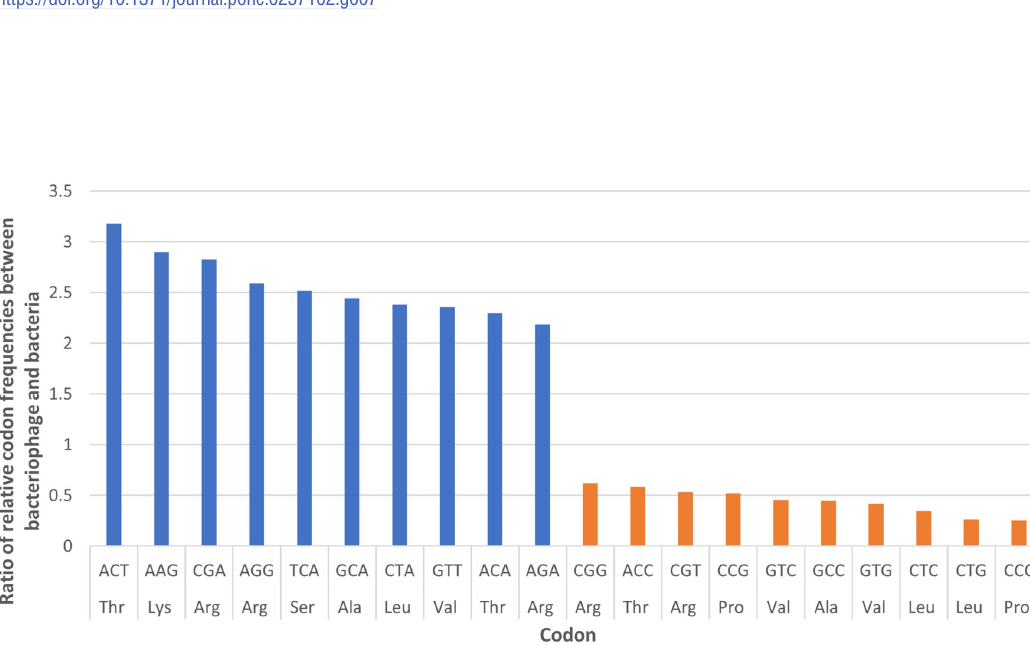
Fig 8. The ratio of relative codon frequencies between bacteriophage KMI8 and K . michiganensis strain KLEB011. The figure shows codons for which KMI8 exhibited the 10 highest (blue) and 10 lowest (orange) relative codon frequencies compared to the host.